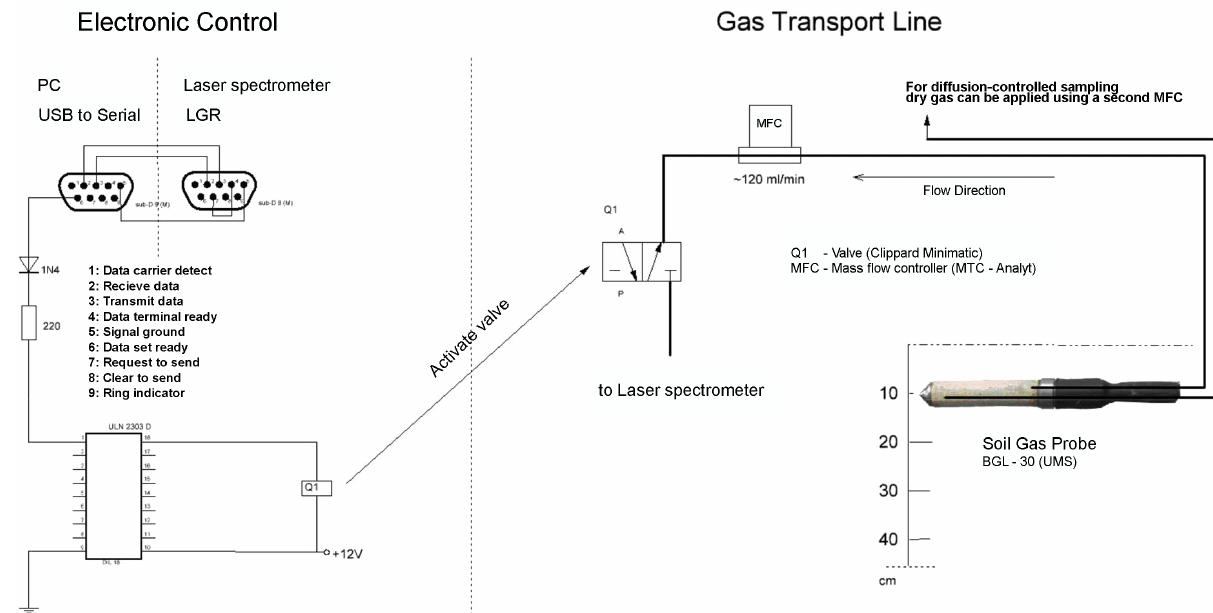
Figure 2. Gas transport (right) is controlled by an automated electronic control (left). The PC mimics the behavior of a laboratory autosampler communicating with the analyzer via a USB-to-serial adapter. High and low signals from the data set ready pin can be used to switch valves using an opto-isolator (ULN2303). Vapor is transported via the transport line from the soil gas probe to the ICOS device. The flow is measured with a mass flow controller